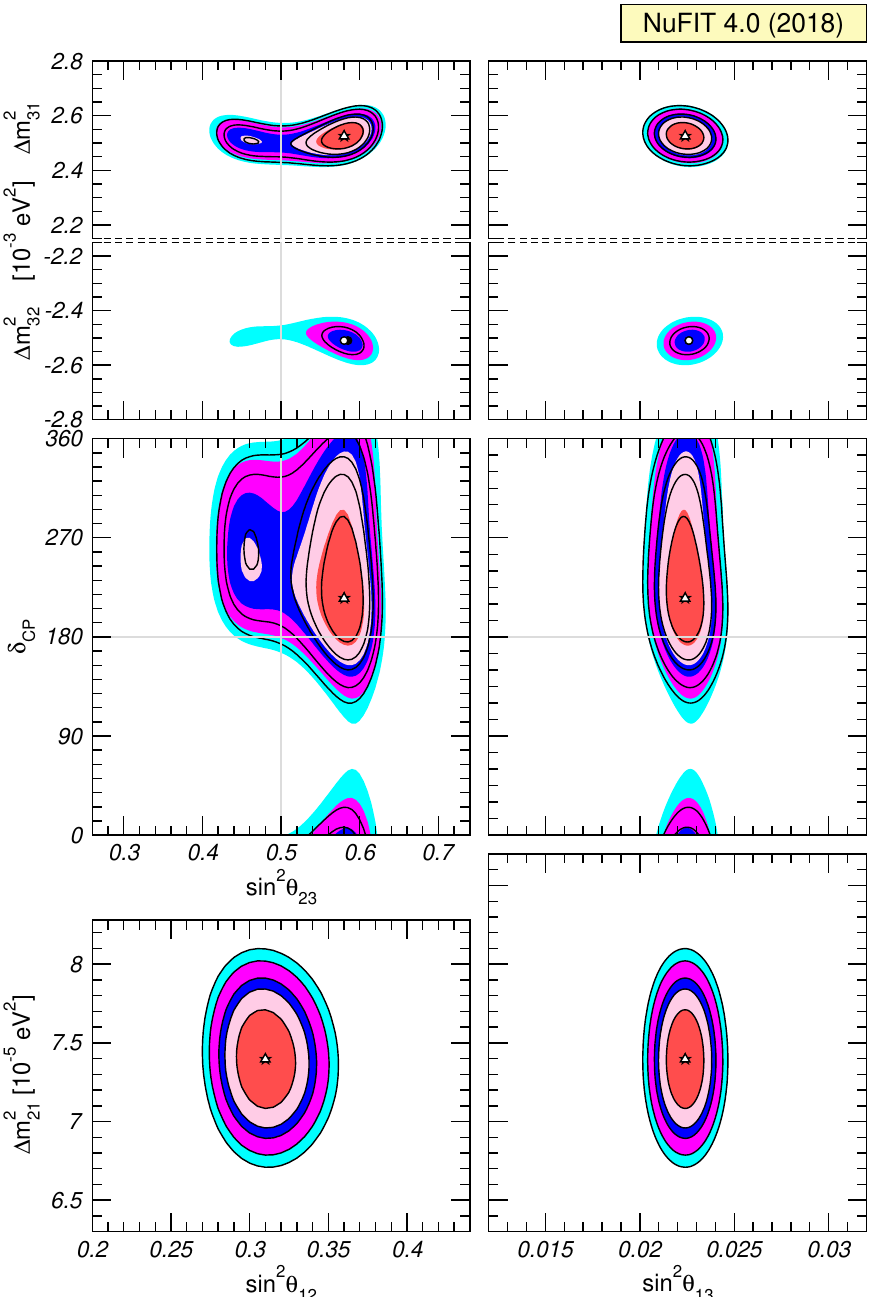
Figure 2 . Global 3 (cid:23) oscillation analysis. Each panel shows the two-dimensional projection of the allowed six-dimensional region after minimization with respect to the undisplayed parameters. The regions in the four lower panels are obtained from (cid:1) (cid:31) 2 minimized with respect to the mass ordering. The di(cid:11)erent contours correspond to 1 (cid:27) , 90%, 2 (cid:27) , 99%, 3 (cid:27) CL (2 dof). Coloured regions (black contour curves) are without (with) adding the tabulated SK-atm (cid:1) (cid:31) 2 . Note that as atmospheric mass-squared splitting we use (cid:1) m 2 for NO and (cid:1) m 2 for IO. 31 32